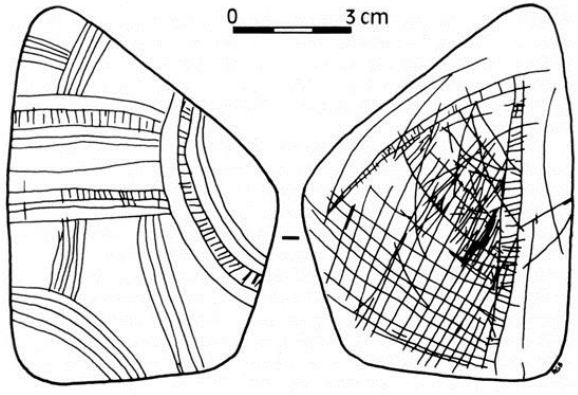
Figure 25. Epipalaeolithic limestone cobble bearing extensive geometric engraved marks on both sides, from Urkan e-Rub,